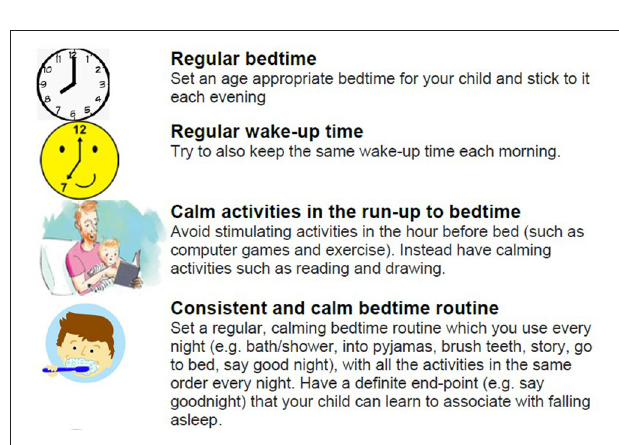
FIGURE 5 | Image of the type of advice and presentation of material for module D, sleep hygiene